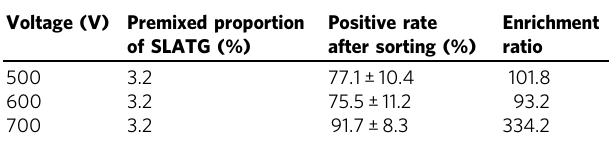
Table 1 Optimization of sorting parameters on FADS for Streptomyces